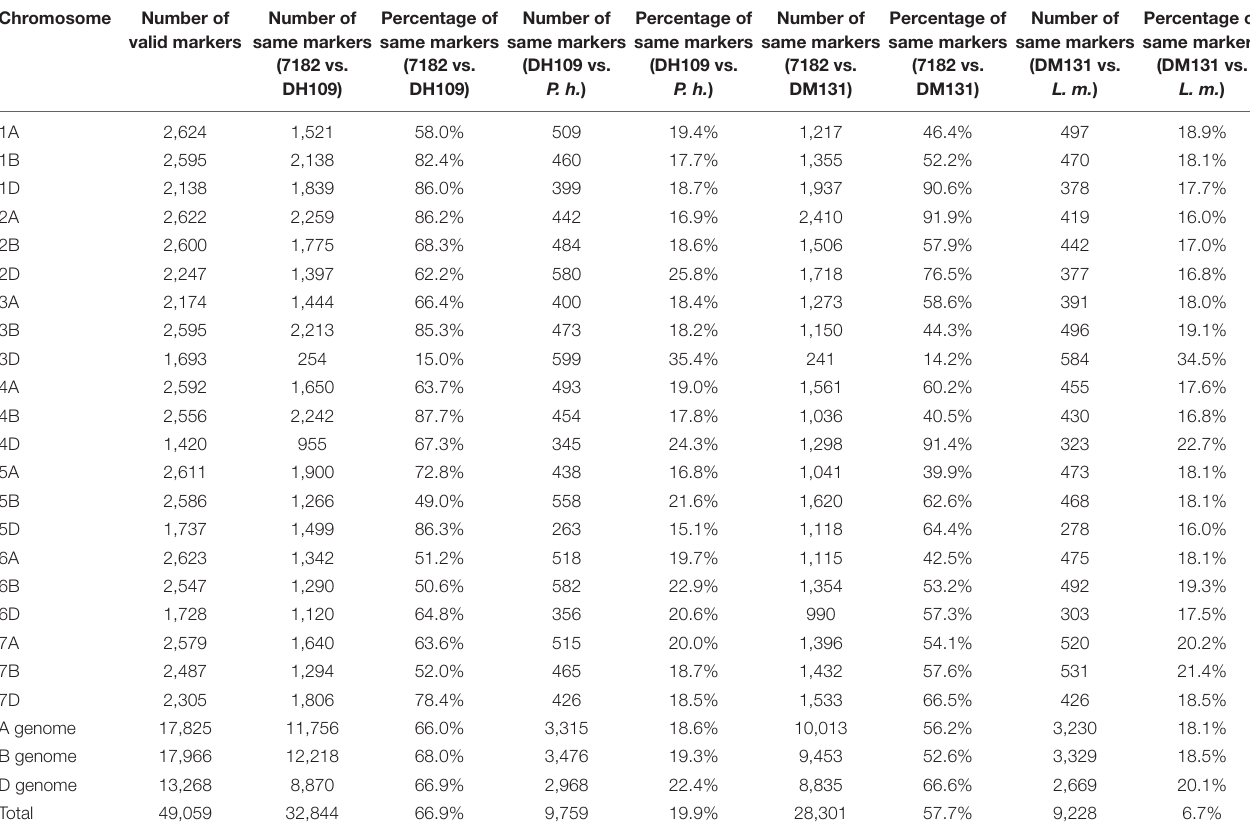
TABLE 3 | Comparison of wheat 55K SNP array data between the two derived lines and their wheat parent 7182. Chromosome Number of Number of valid markers same markers